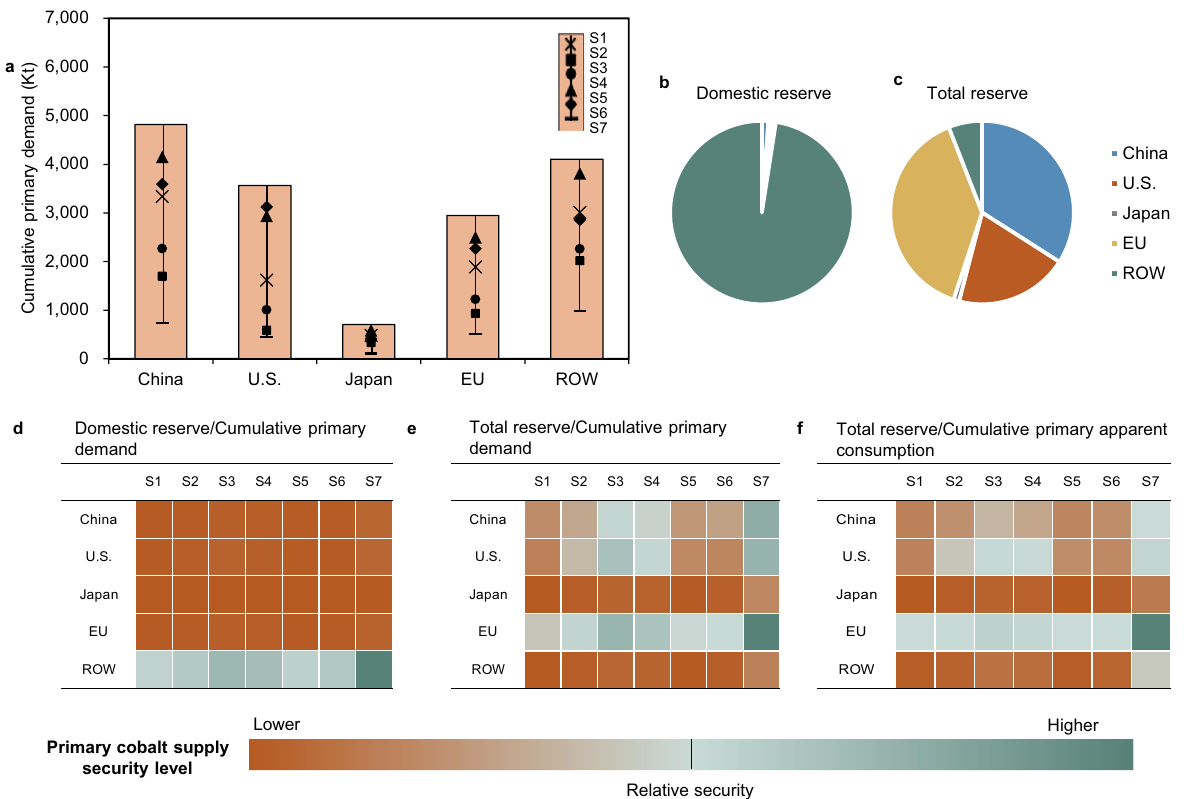
Fig. 4 Prospective cumulative primary demand, domestic and total reserve, and corresponding supply security levels under the seven selected scenarios. a The regional cumulative primary demand (gross demand minus secondary supply) under the seven scenarios from 2020 to 2050; b shares of domestic reserves by region in 2019; c shares of total reserves (domestic reserves plus overseas cobalt reserve ownership 88 ) by region in 2019 and the primary cobalt supply security level during 2020 – 2050 measured by d domestic reserve divided by cumulative primary demand; e total reserve divided by cumulative primary demand; and f total reserve divided by cumulative primary apparent consumption (primary demand plus net export of cobalt fi nal products, which are assumed the same as the 2019